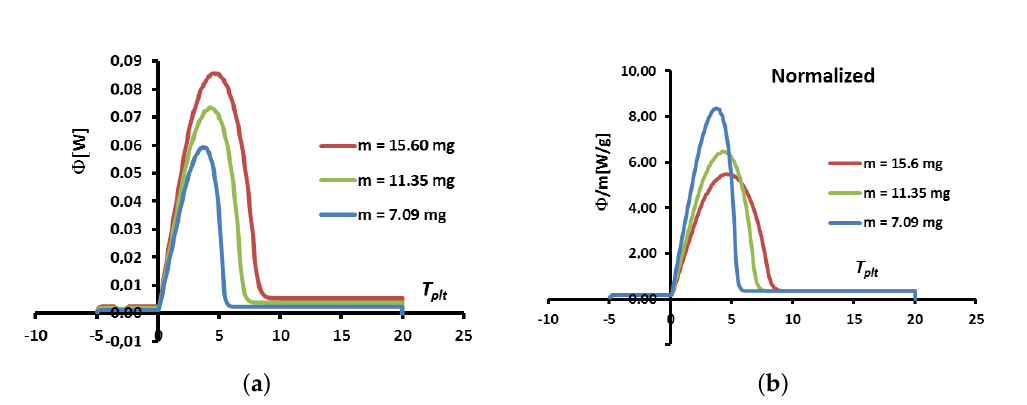
Figure 10. DSC curves at various masses for the heating at 5 K/min of a pure substance (water). ( a ) Basic thermogram; ( b ) Normalized